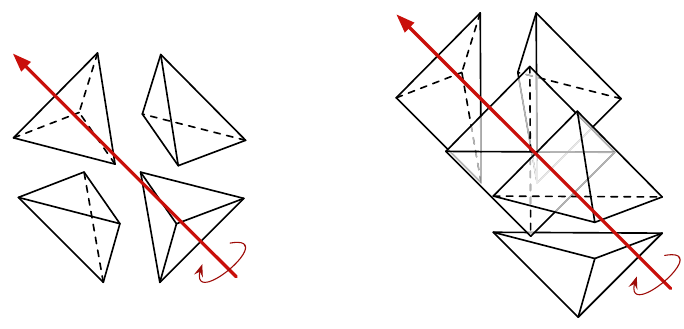
Figure 8 . A 180 ◦ rotation relates the top sequence of triangulated octahedra to the bottom sequence. Here the triangulated octahedra I and IV are depicted, for which the rotation is a symmetry. (In contrast, octahedra II VI and III V are ↔ ↔